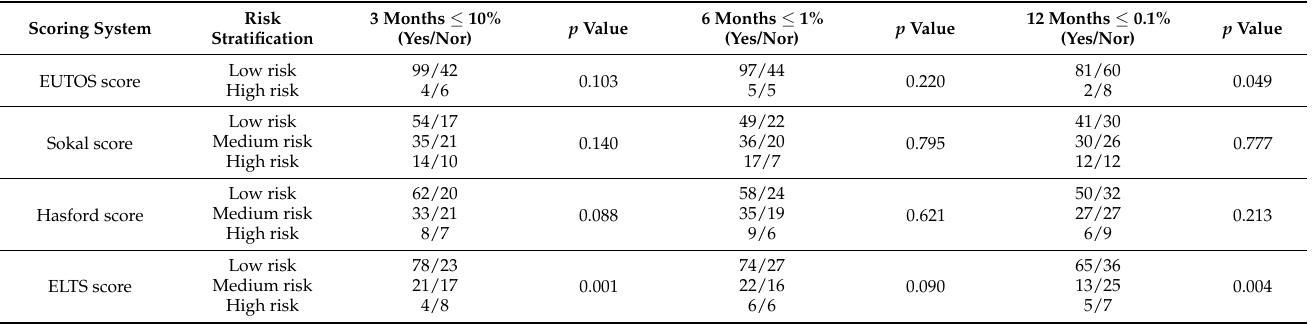
Table 6. Analysis of scoring systems on the molecular response of 151 CML-CP patients.